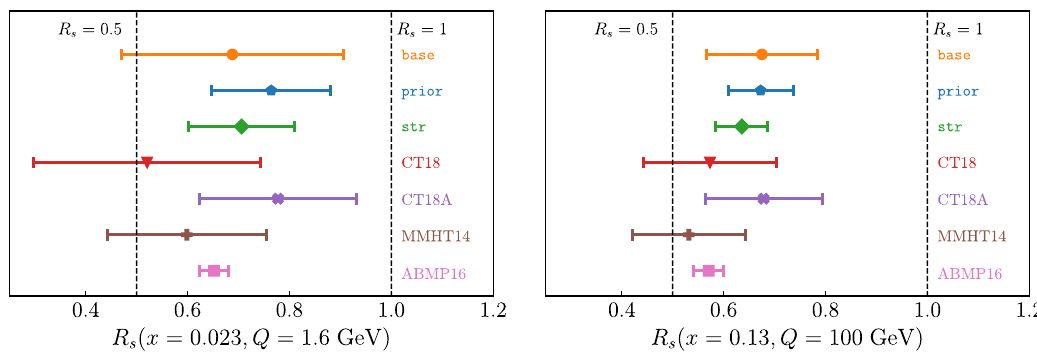
Fig. 10 The ratio R s , Eq. (3.1), computed at x = 0 . 023, Q = 1 . 6 GeV (left) and x = 0 . 13, Q = 100 GeV (right). The PDF sets are from the str_base , str_prior , str fits and from other recent PDF analyses; see the text for details